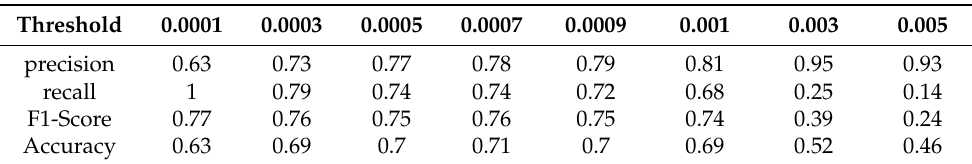
Table 5. The Thresholds of Pearson’s Correlation Difference and Their Corresponding Fault Detection Accuracy, Precision, Recall, and F1-Score.